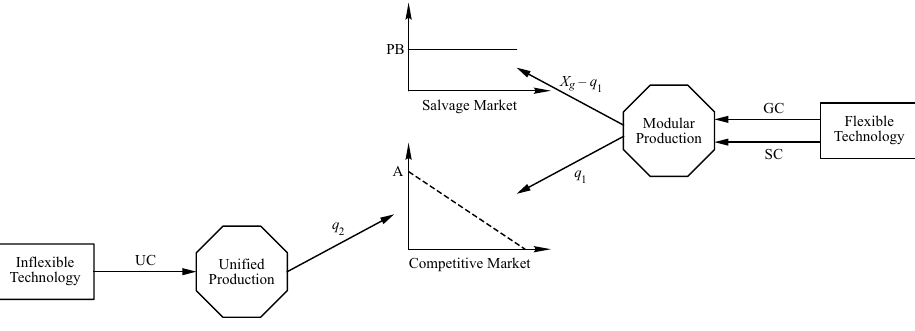
Fig. 2. Modular vs. unified production